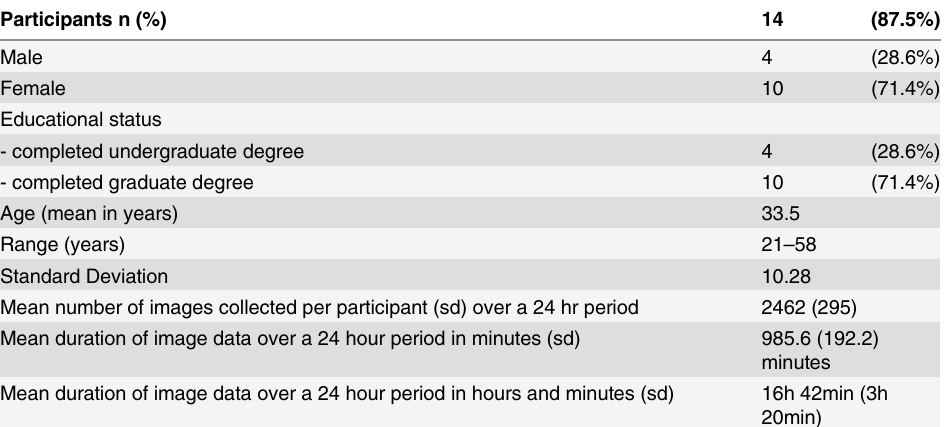
Table 1. Participant demographics and image collection results for n = 14 who completed the study